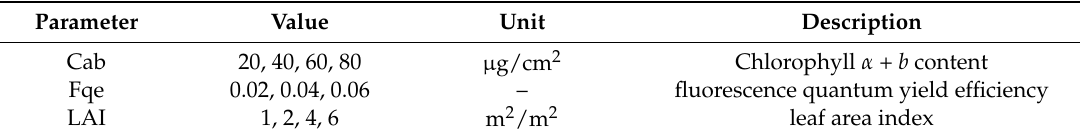
Table 2. Input parameters of SCOPE in this paper.